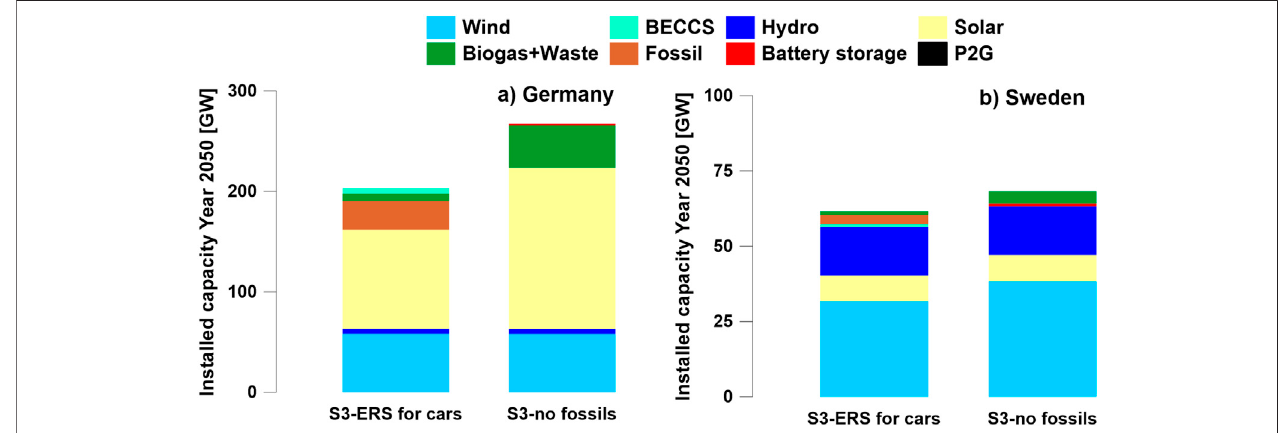
FIGURE 8 | Sensitivity analysis in ELIN-EPOD for Germany and Sweden. The same scenario as S3-V2G40%-ERS but with the addition of: (A) an introduction of ERS for passenger cars (S3-ERS for cars); and (B) no investments in fossil fuel-based technologies (S3-no fossils).